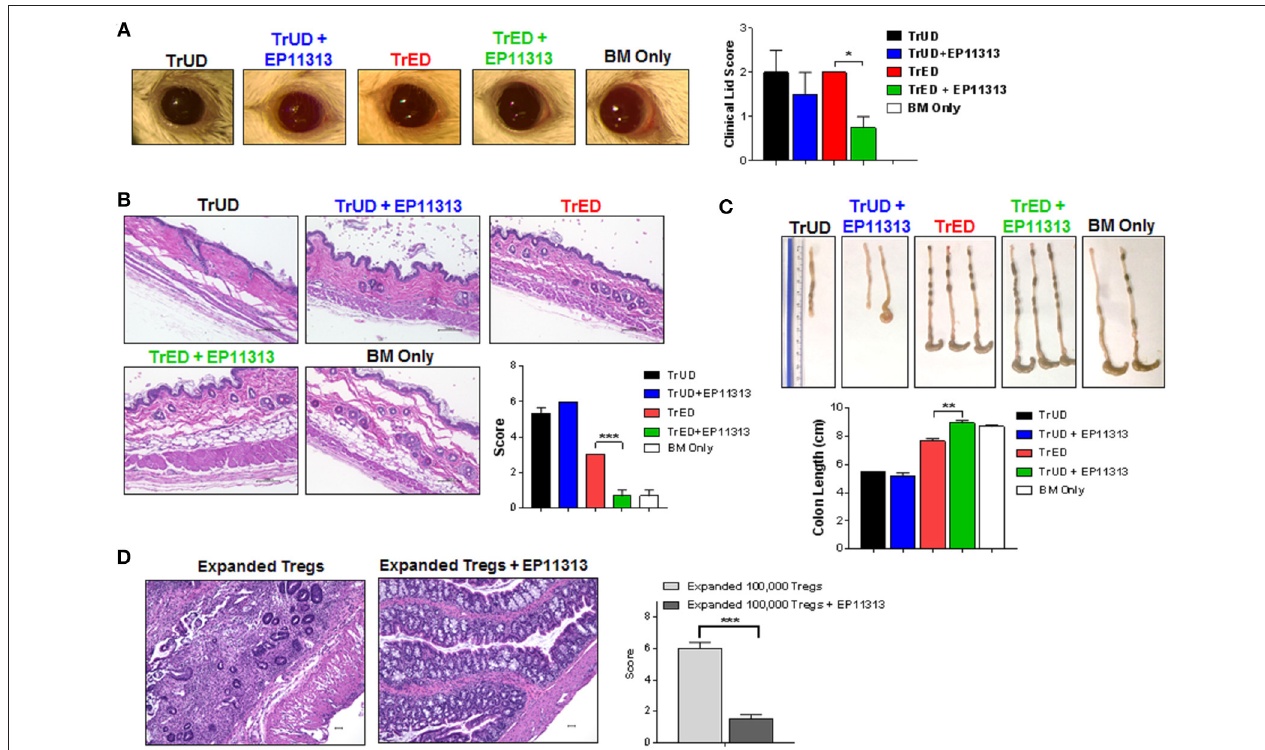
FIGURE 6 | Diminished GVHD in target tissues of recipients treated with EP11313 and TrED. A complete MHC-mismatched aHSCT was performed (as in Figure 5 ) by transplanting 5.5 × 10 6 TCD B6-CD45.1 BM cells and spleen cells from expanded (TL1A-Ig + low dose IL-2: TrED group) or unexpanded B6-FoxP3 RFP (TrUD) donor mice adjusted to contain 1.0 × 10 6 total T cells. EP11313 10 mg/kg or vehicle were given i.p. from day − 2 to 4 post-HSCT. Four to seven weeks after transplant, (A) Representative photographs of clinical ocular differences from the indicated groups (left) and diminished lid scores (right) in TrED + EP11313 treated groups vs. TrED (4 weeks post-transplant) (A) . Representative H&E stained sections from skin 5 weeks after aHSCT showed that TrED + EP11313 treatment resulted in more normal architecture with less fibrosis and dermal thickening (B) . Pathology scores for these tissues are shown (B) . Colon length 7 weeks post-aHSCT was longer in recipients of TrED + EP11313 treatment (C) . Representative H&E stained sections from colon 5 weeks after aHSCT of mice treated with 100,000 expanded donor Tregs ± EP11313. Colons from 100,000 expanded Tregs + EP11313 recipients showed mild inflammation and no distortion of the villi compared with colons from 100,000 expanded Tregs alone. Pathology scores for these tissues are shown on the right (D) . Magnification 100 × for colon and 200 × for skin. Values are means ± SEM. * p < 0.05; ** p < 0.01; *** p <